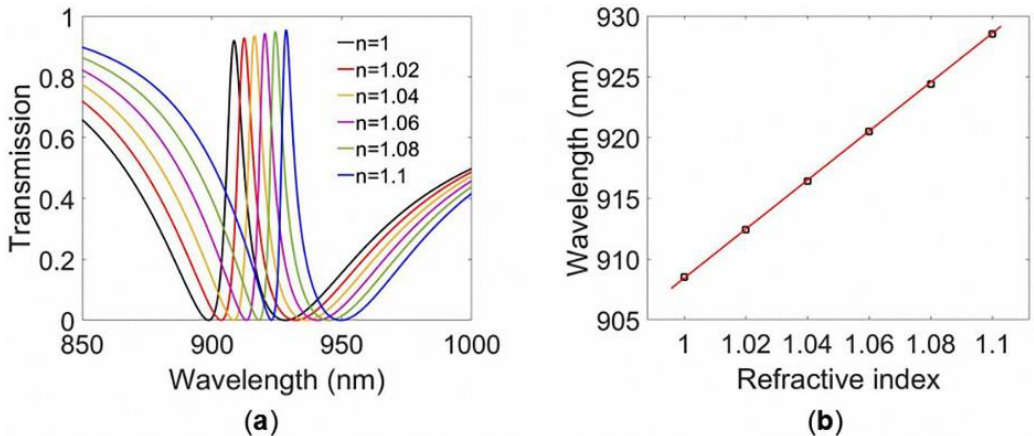
Figure 6. ( a ) Simulated transmission spectra of the metamaterial structure with refractive index ranging from 1 to 1.1. ( b ) The EIT-like peak wavelength of the metamaterial structure as a function of refractive index. The squares are the measured data, and the red line is the linear fit.